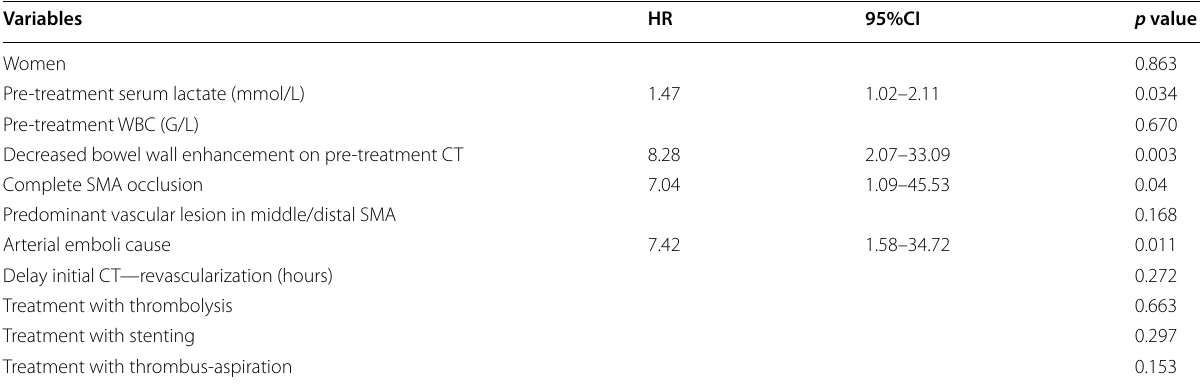
CI confidence interval; CT (computed tomography); HR (hazard ratio); HR hazard ratio; SMA (superior mesenteric artery); and WBC (white blood cells)